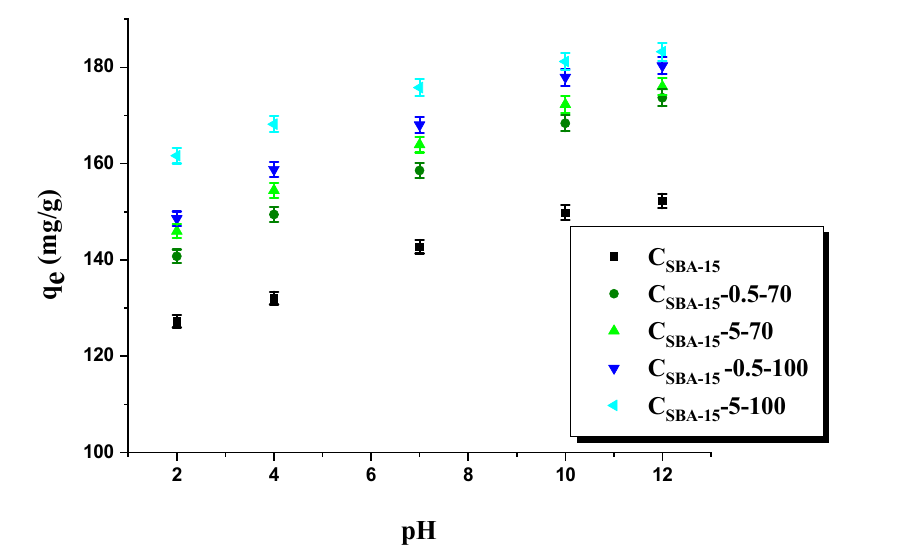
Figure 4. The pH influence on the sorption capacity of adsorbents obtained.